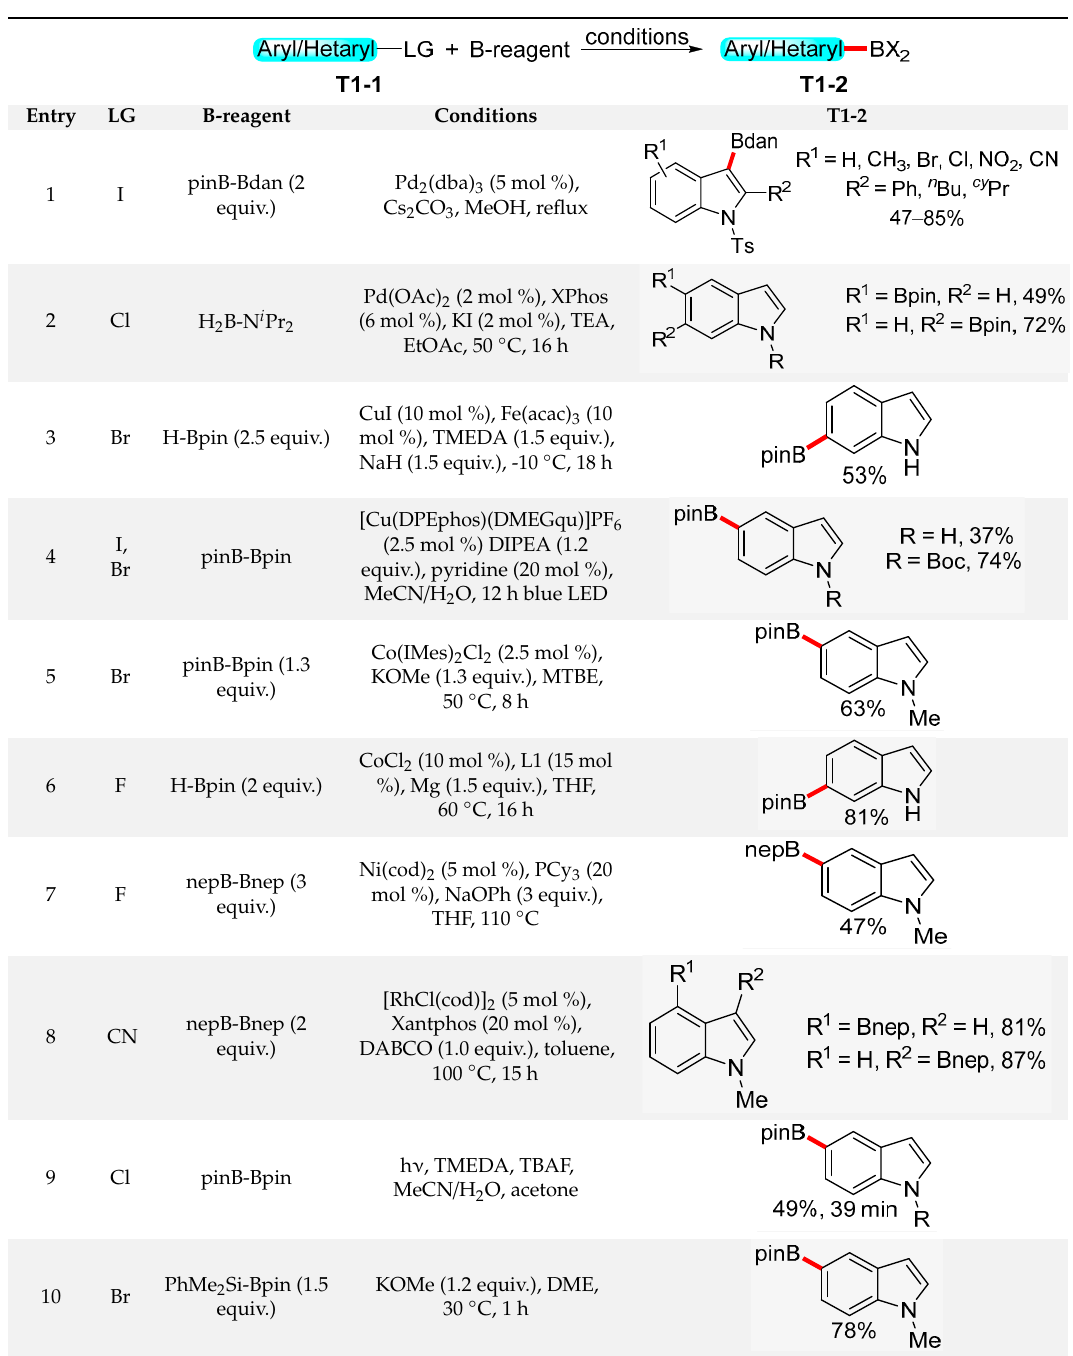
Molecules 2019 , 24 , x FOR PEER REVIEW Table 1. The preparation of indolylboronates by means of Miyaura borylation. Table 1. The preparation of indolylboronates by means of Miyaura borylation. Table 1. The preparation of indolylboronates by means of Miyaura borylation. Table 1. The preparation of indolylboronates by means of Miyaura borylation. Table 1. The preparation of indolylboronates by means of Miyaura borylation. Table 1. The preparation of indolylboronates by means of Miyaura borylation. Table 1. The preparation of indolylboronates by means of Miyaura Table 1. The preparation of indolylboronates by means of Miyaura borylation. Table 1. The preparation of indolylboronates by means of Miyaura borylation. Table 1. The preparation of indolylboronates by means of Miyaura borylation. Table 1. The preparation of indolylboronates by means of Miyaura borylation. Table 1. The preparation of indolylboronates by means of Miyaura borylation.